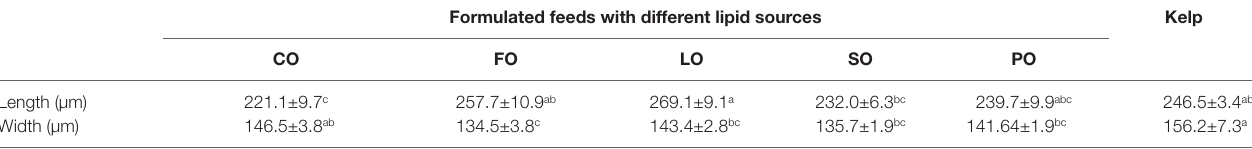
TABLE 5 | Effects of different lipid sources on prismatic larvae size of sea urchin ( Strongylocentrotus intermedius ) (mean ± SEM, n=3) 1. Formulated feeds with different lipid sources